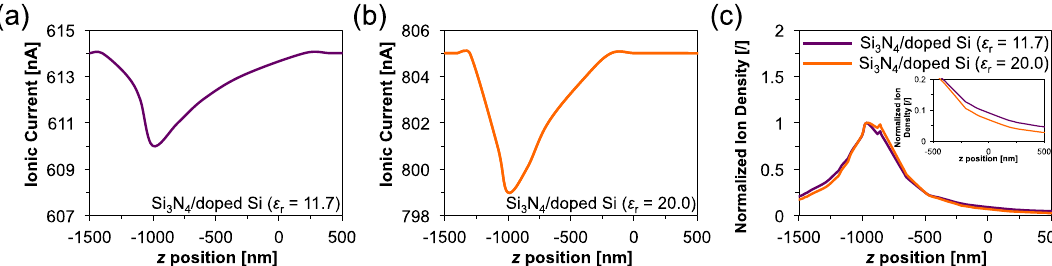
Figure 6. Simulated ionic current blockades. ( a ) Ionic current dependence in z position of a 30-nm-diameter nanoparticle in the Si 3 N 4 /doped Si ( ε r = 11.7) nanopore. ( b ) Ionic current dependence in z position of a 30-nm-diameter nanoparticle in the Si 3 N 4 /doped Si ( ε r = 20) nanopore. ( c ) Normalized dependences of ion density in z position in each nanopore device and the extended figure of the dependences in z = −500–500 nm (inset).